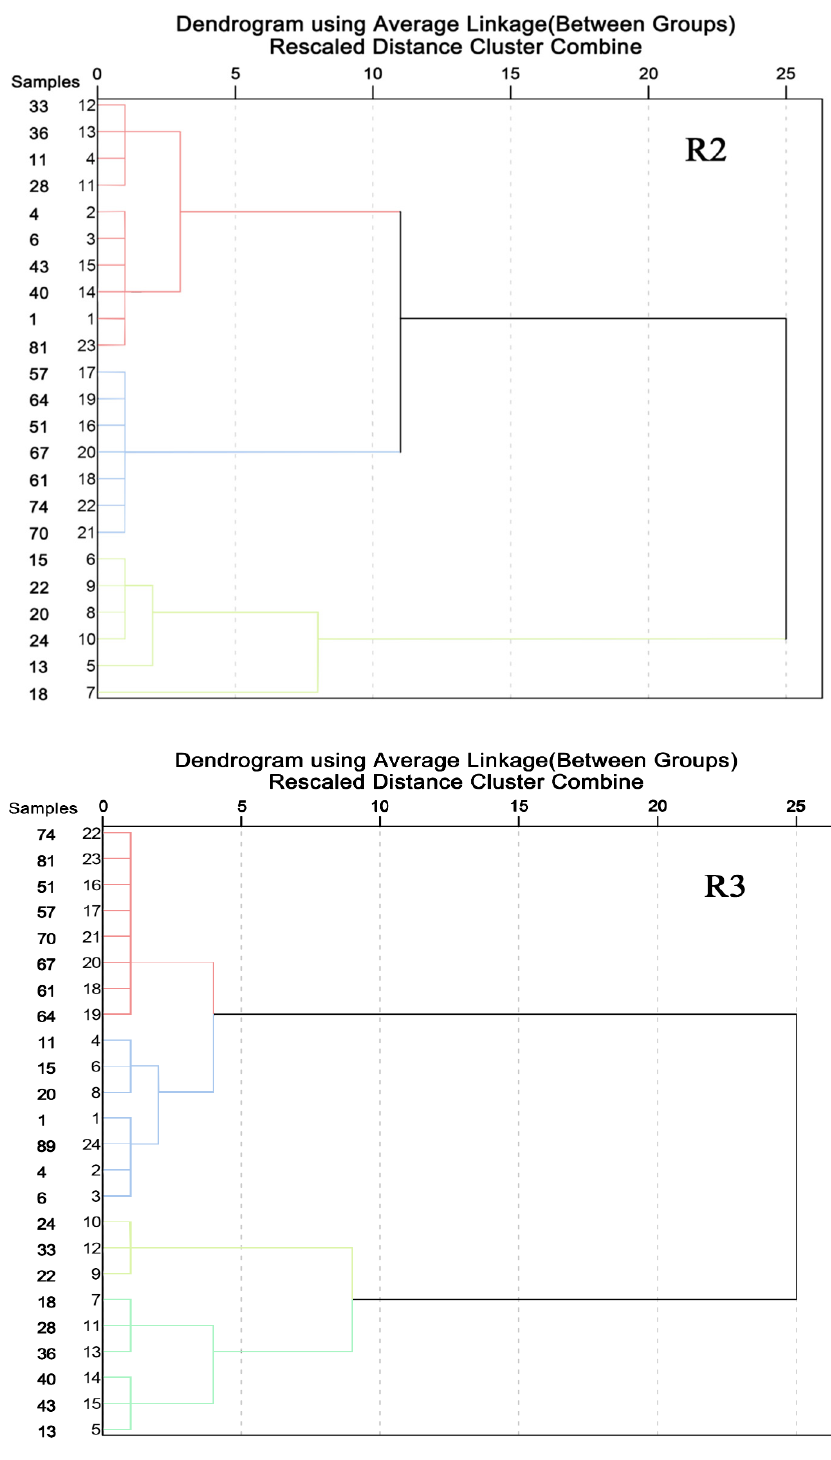
Figure 4. The clustering results of aerobic granules formation process (1) R1, (2) R2, (3) R3.